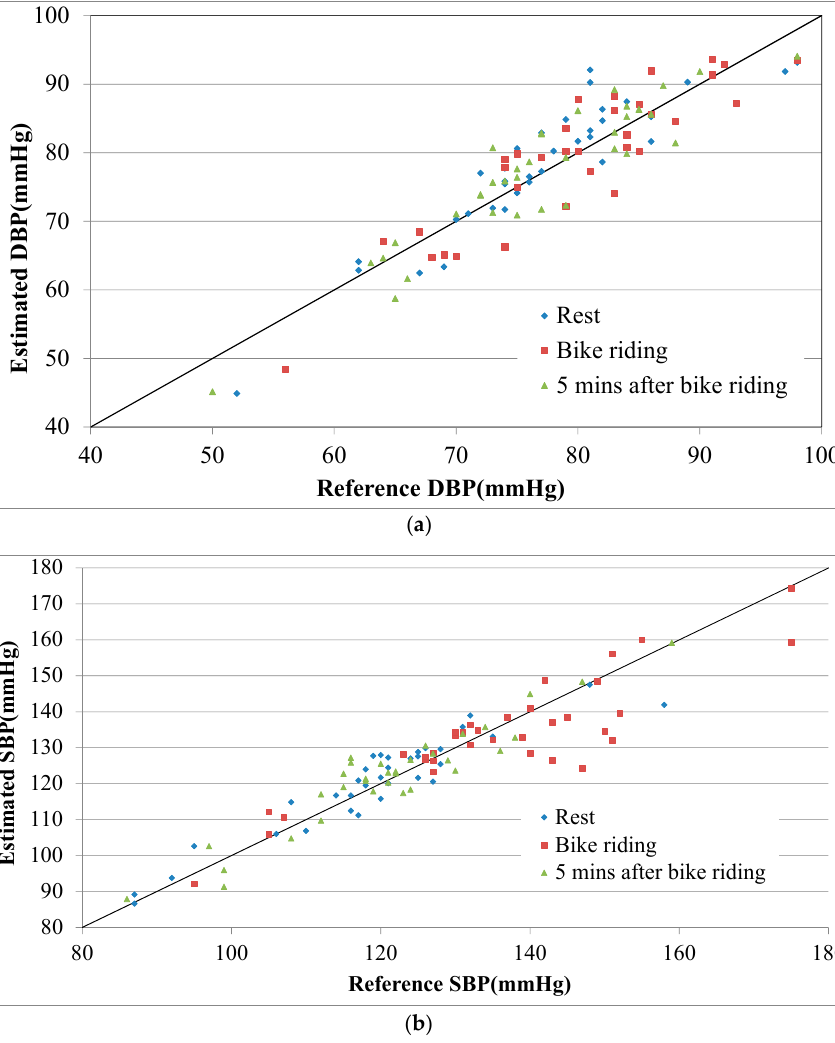
Figure 14. Scatter plot of participants’ reference and estimated BPs. ( a ) DBP and ( b ) SBP. In the high-intensity exercise group, the respective DBP and SBP differences between values obtained during rest and exercise were 4.52 and 12.11 mmHg in the calibration. The participants then engaged in high-intensity bike riding, increasing their SBPs to an average of 152.28 mmHg. The errors and averages of the estimated BPs for the 20 participants are listed in Table 2. The mean and average errors for BP values increased slightly both during and after bike riding, as denoted in Tables 1 and 2. A percentage error index was defined as Equation (10) to determine whether the percentage error, E p , of the estimation model increased with BP.